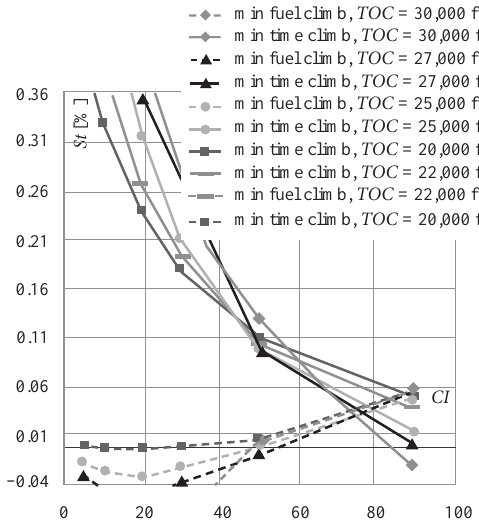
Fig. 8. Determination of the range of use of minimum costs climb technique, m cl 1 = 61,000